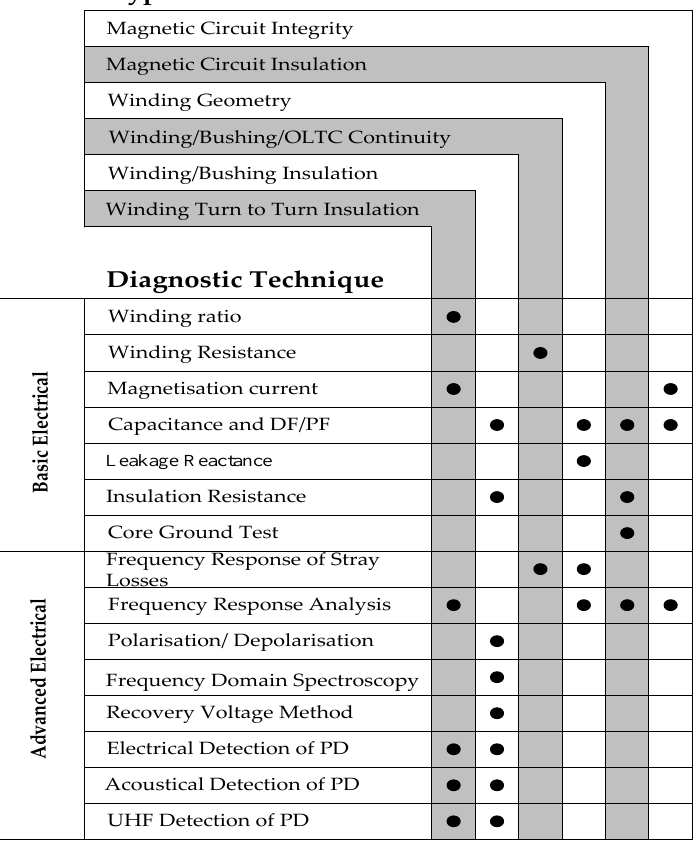
Figure 1. Electrical Tests Diagnostic Matrix, based on the one proposed in [2]. OLTC: on load tap changer; DF: dissipation factor, PF: power factor; PD: partial discharge; UHF: ultra high frequency.